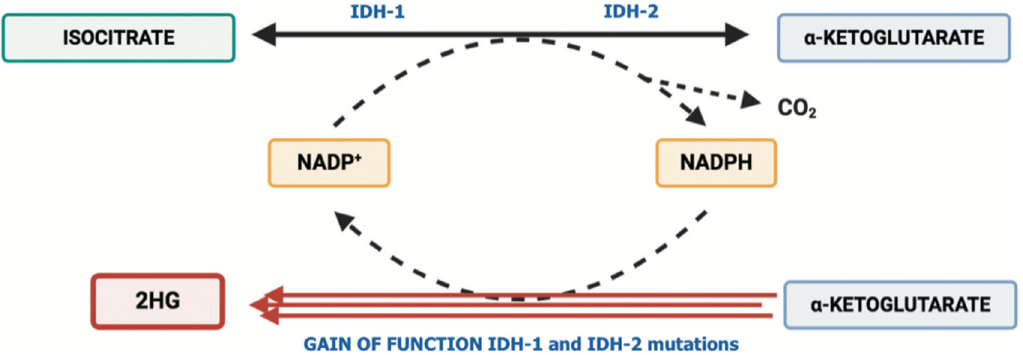
Figure 1. Schematic representation of IDH1 and IDH2 mutations determining the pathological accumulation of 2-HG.